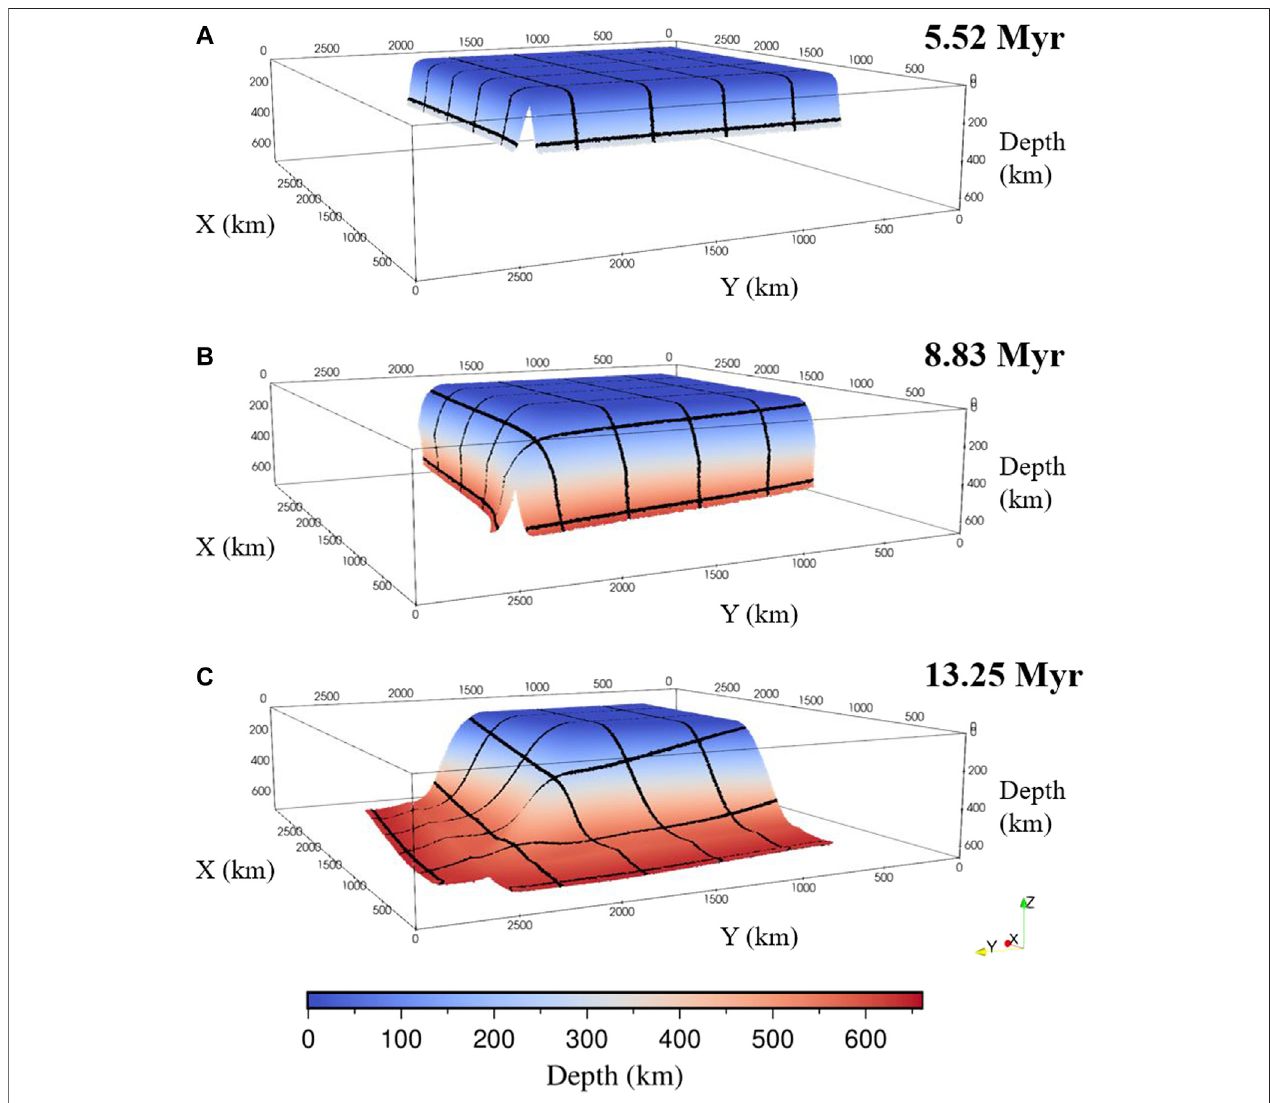
FIGURE 3 | The evolution of slab morphology at 5.52 (A) , 8.83 (B) , and 13.25 (C) Myr in the reference model. The color indicates the depth of the slab. We put some black tracking lines on the slab surface to better display the three-dimensional structure of the slab.